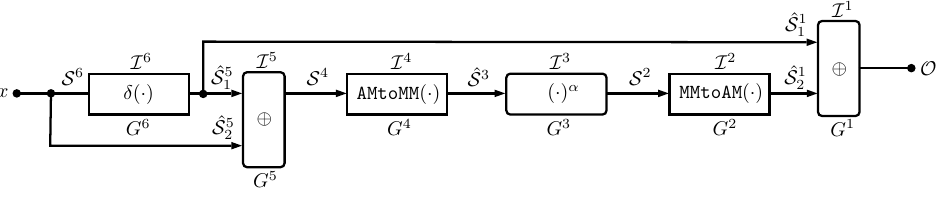
Figure 3: GPQ secure Gadget ( · ) α